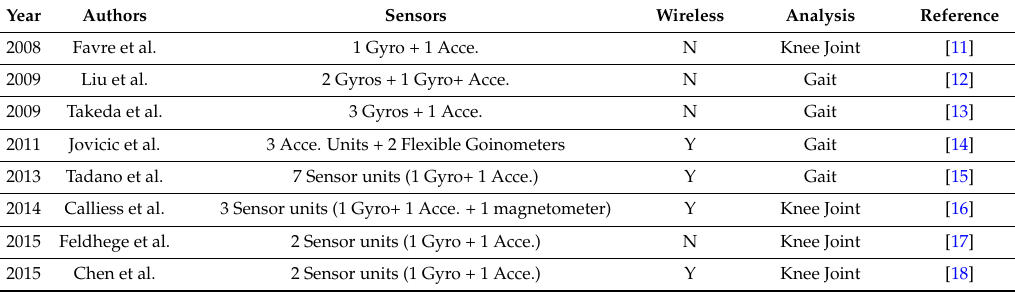
Table 1. Related works on skeleton-based monitoring